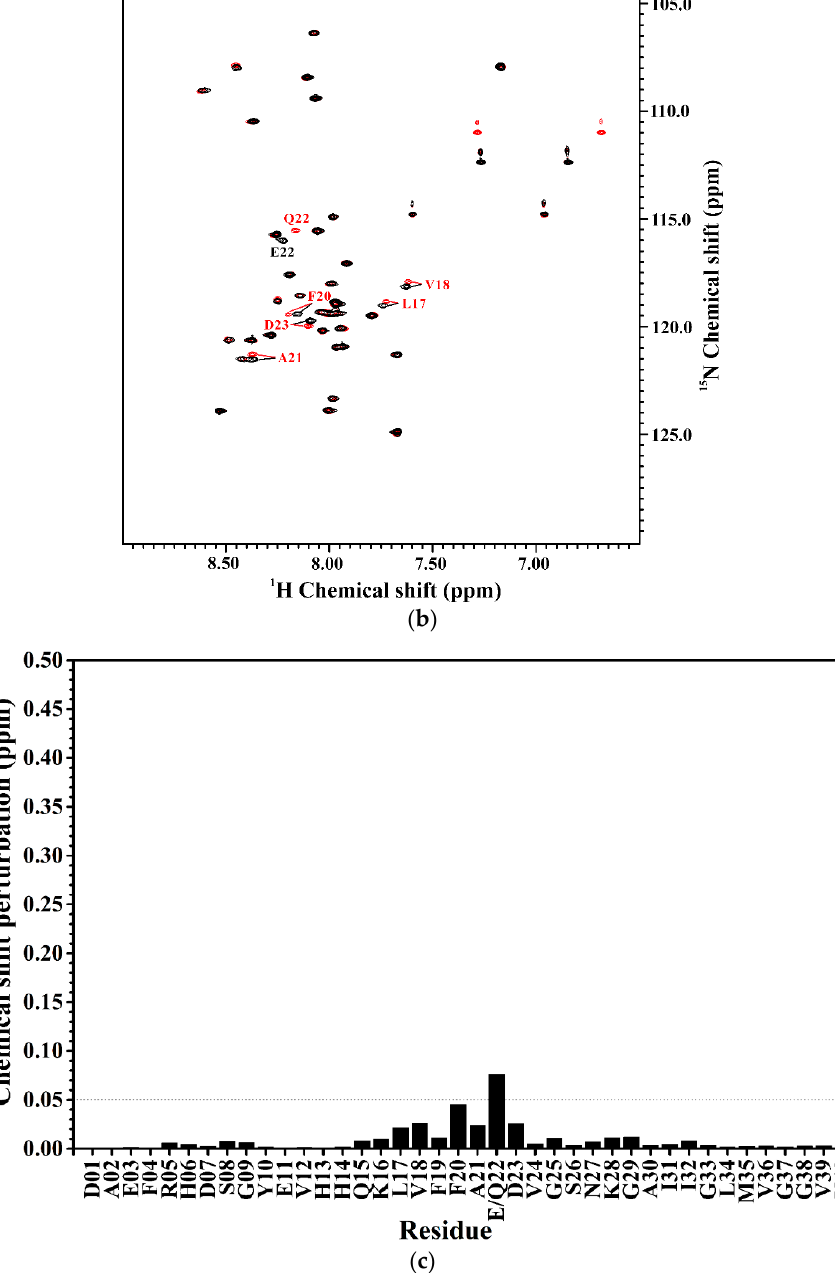
Figure 2. ( a ) Two-dimensional 1 H- 15 N-HSQC spectrum of 15 N-labeled A β 40 (E22Q) in 100 mM SDS micellar solution at 296 K; ( b ) Overlay of two-dimensional 1 H- 15 N-HSQC spectra of 15 N-labeled wild-type A β 40 (black) and A β 40 (E22Q) (red) in 100 mM SDS micellar solution at 296 K. Residues which display chemical shift perturbations were labeled; ( c ) Chemical shift perturbation plotted as a function of residue number. Chemical shift perturbation was calculated using the equation [( HN Δ ppm) 2 + (N Δ ppm/10) 2 ] 1/2 , where HN Δ ppm and N Δ ppm were equal to 1 H N and 15 N chemical shift differences between wild-type A β 40 and A β 40 (E22Q), respectively [31].